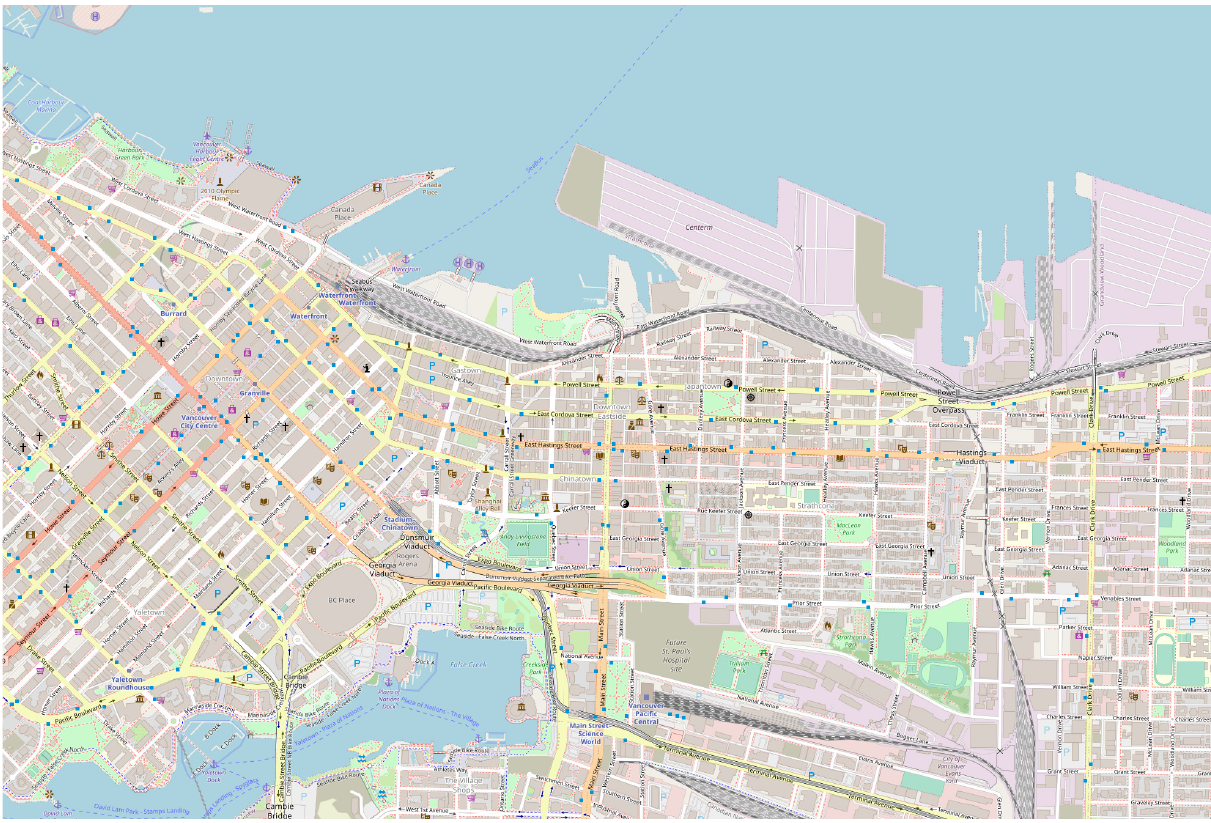
Figure 1. The location of the Downtown Eastside in Vancouver. Source: © OpenStreetMap contributors, CC‐BY‐SA. there is considerable and growing socio‐economic diver‐ sity within the population of the Downtown